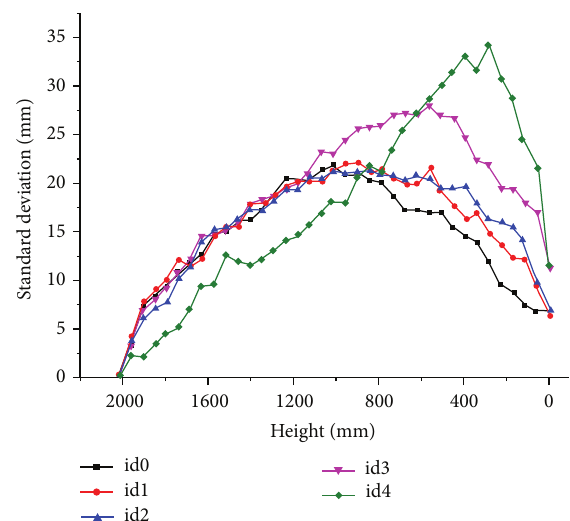
Figure 8: The standard deviations of tracks in the heightened